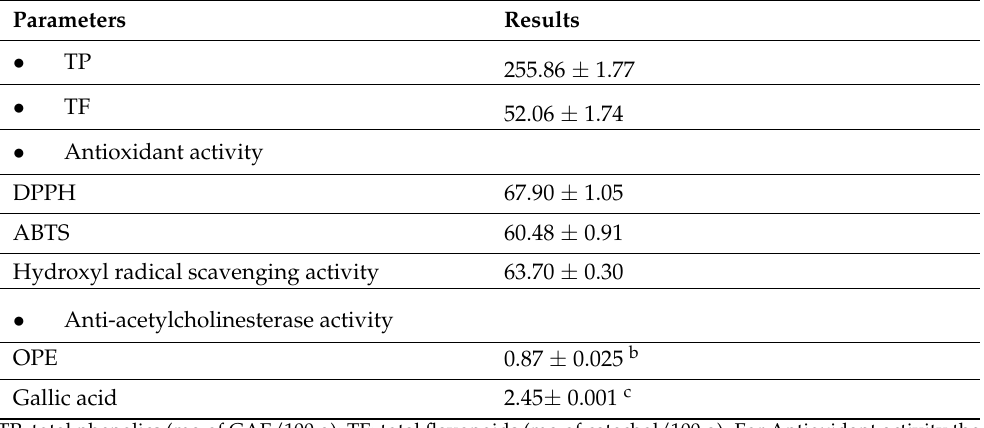
Table 1. Orange peel extract (OPE) total phenolic, total flavonoids, and its functional properties.